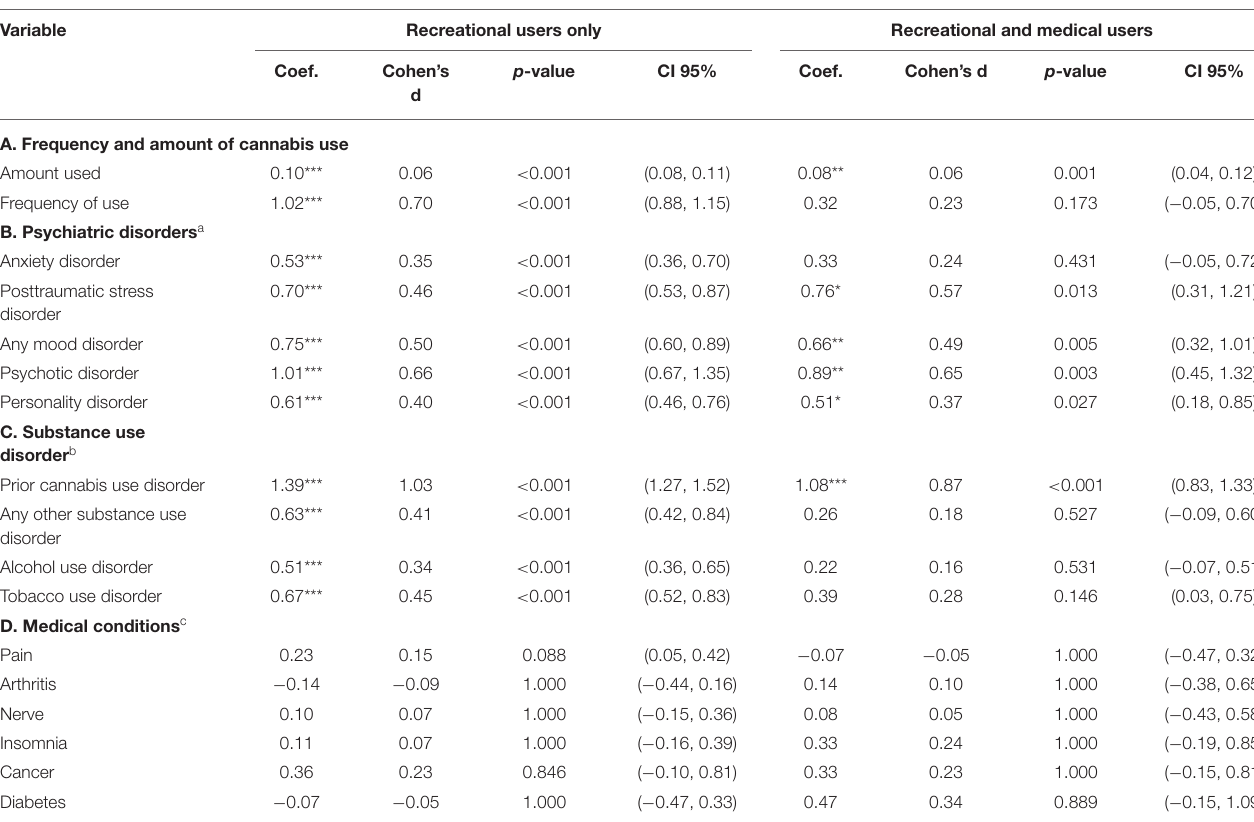
TABLE 4 | Association between respondents’ mental, medical, and substance use morbidity, frequency and amount of use, and number of cannabis use disorder criteria (Diagnostic and Statistical Manual of Mental Disorders, Fifth Edition). Variable Recreational users